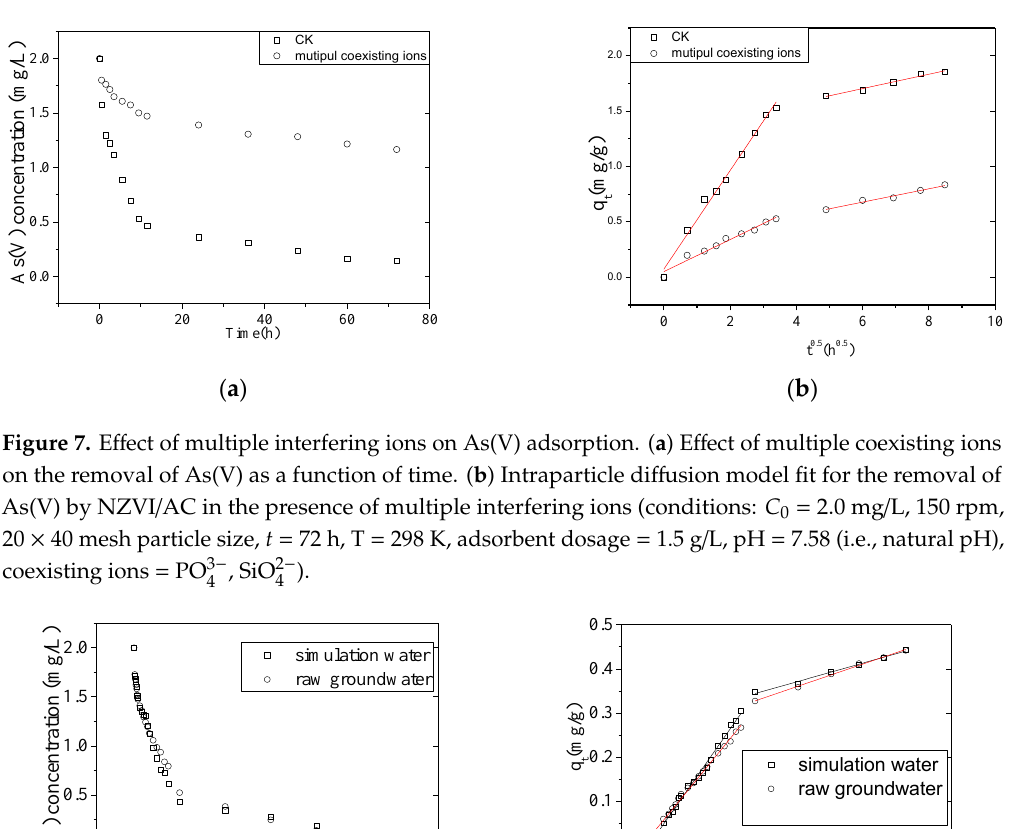
Figure 8. Adsorption of As(V) from raw groundwater. ( a ) Performance of NZVI/AC in the removal of As(V) from raw groundwater compared with water containing only As(V). ( b ) Intraparticle diffusion model fit for the As (V) removal by NZVI/AC in raw groundwater compared to simulation water containing only As(V) (conditions: C 0 = 2.0 mg/L, 150 rpm, 20 × 40 mesh particle size, t = 72 h, T = 298 K, adsorbent dosage = 4.5 g/L, pH = 6.5). Table 8. Rate constants for the kinetic model of As(V) adsorption on NZVI/AC. Comparison of simulation water containing only As(V) vs. raw groundwater.